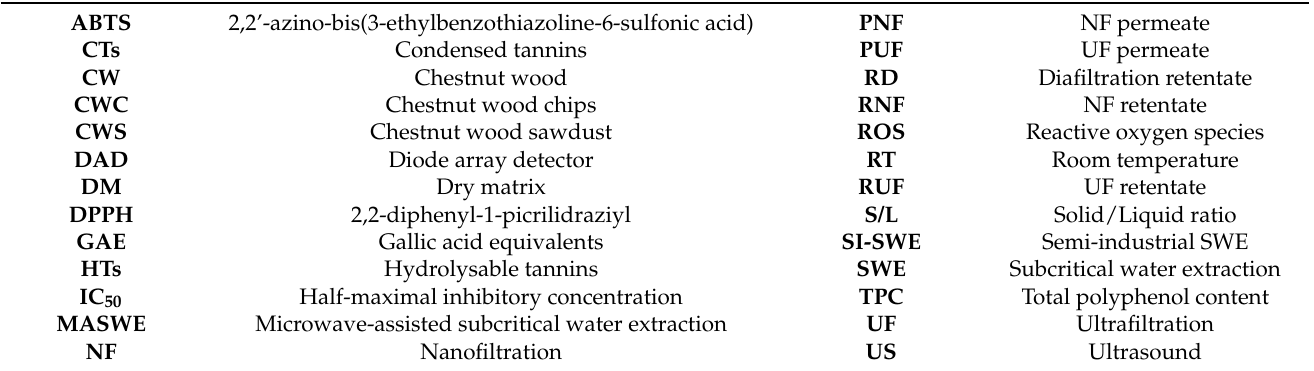
Table 1. List of